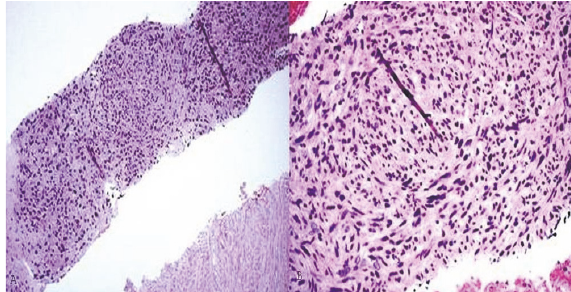
Figure 4: (a) Spindle cell neoplasm with extensive tumor necrosis. (b) High power view showing fascicular growth pattern and cyto- logical